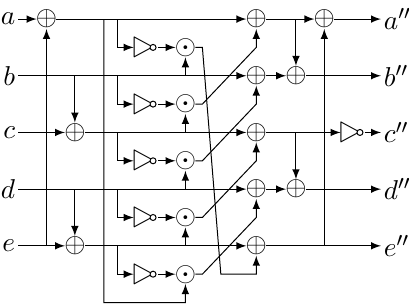
Figure 5: Ascon ’s original S-box, with collisions in a to